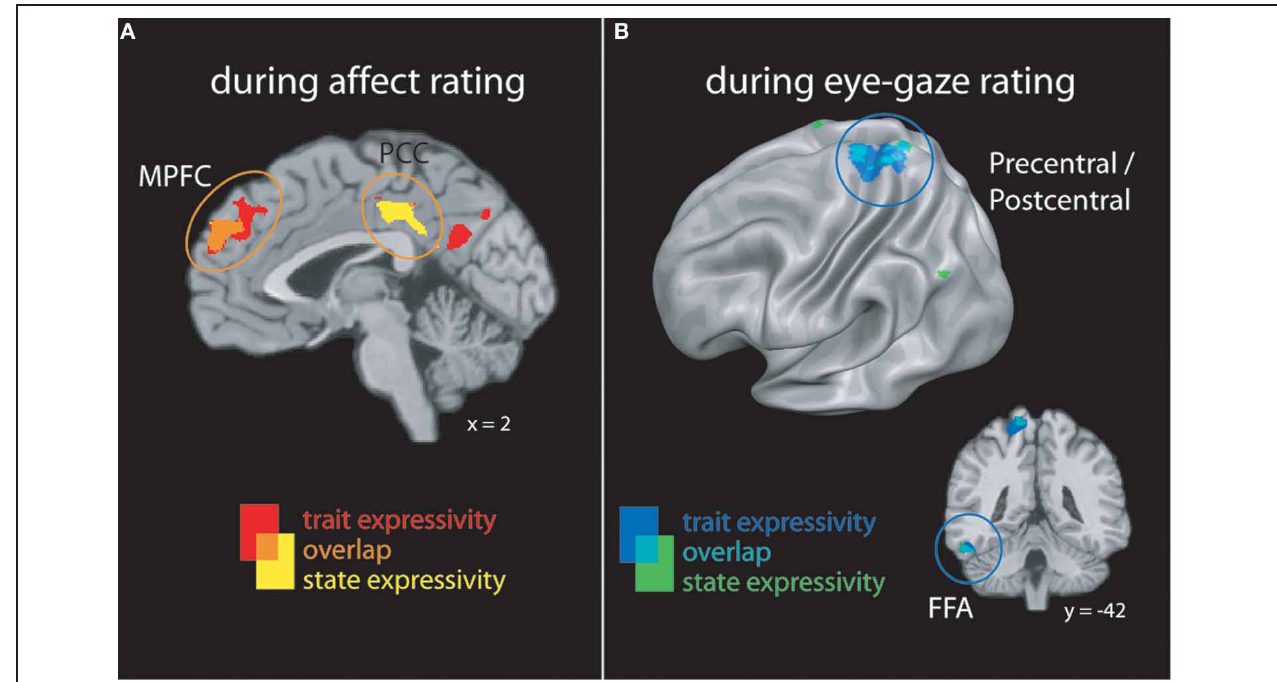
FIGURE 2 | (A) Clusters whose activity tracked with targets’ trait or state expressivity during emotion rating . (B) Clusters whose activity tracked with targets’ trait or state expressivity during eye-gaze rating . FFA, fusiform face area; MPFC, medial prefrontal cortex; PCC, posterior cingulate cortex.